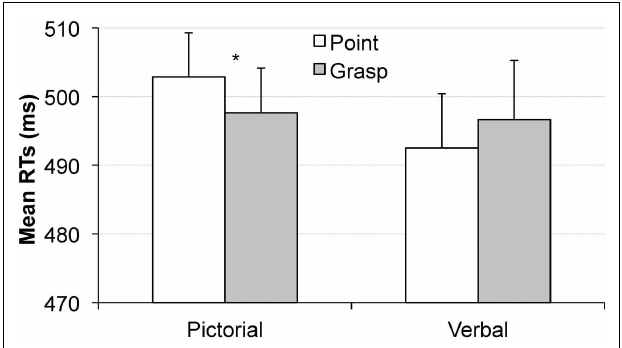
FIGURE 4 | Mean reaction times in the visual search task obtained in Experiment 1 as a function of pointing (white bars) or grasping (gray bars) for the pictorial cue condition (left) and the verbal cue condition (right). The congruency effect was observed for the pictorial cue condition but not the verbal cue condition. Error bars represent standard errors adjusted to within-subject designs, calculated according to the procedure described in Cousineau